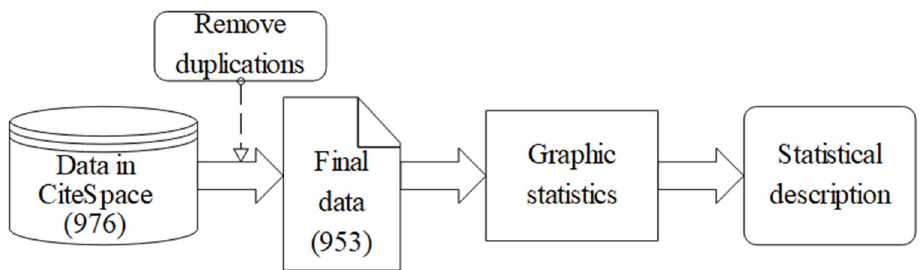
Figure 4. Flowchart of data processing in the bibliometric analysis.